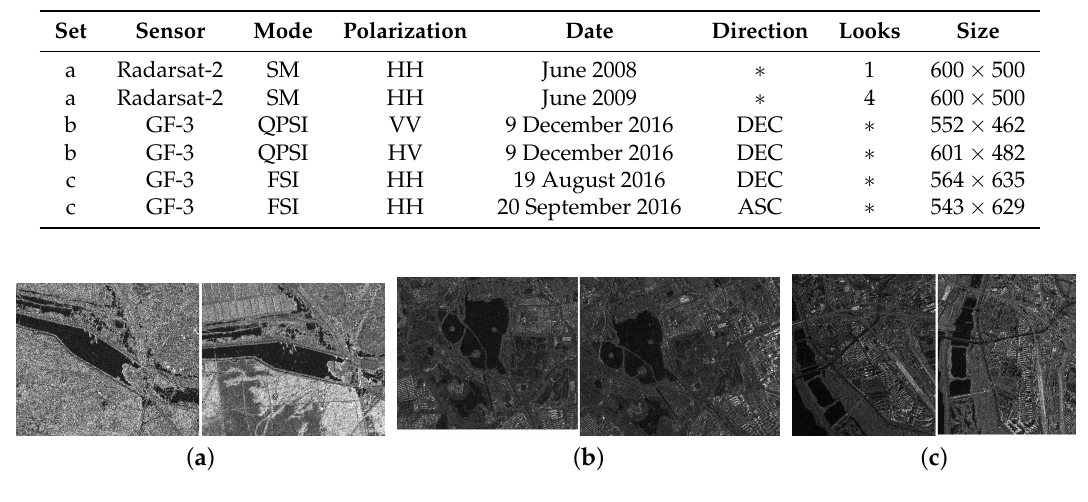
Figure 5. Image pairs. ( a ) the first; ( b ) the second; ( c ) the